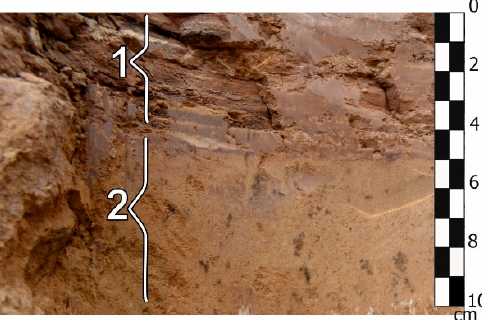
Figure 5. Sharp contact of Chocolate clays (1) with underlying loess and sand layers, MIS 3 (Figure 2).